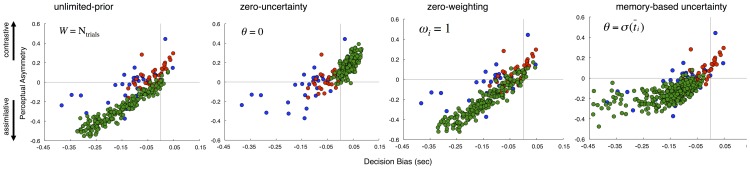
Alternative model comparisons.Each graph displays the results of 200 permutations of an alternative model (green points) compared with the original model (faded points). Four models were tested: an unlimited-prior model, which assumed a perfect memory prior that continuously integrated all perceived intervals across the entire session; a zero-uncertainty model, where uncertainty in the comparison of the present duration with the mean of the prior did not impact decisions and θ was set to zero; a zero-weighting model, in which the prior was still limited and varied between permutations, but no adaptation weighting was applied (all remembered intervals contributed equally to the prior); a memory-based uncertainty model, where θ was set to match the variability of the intervals stored in the limited memory prior. None of the alternative models reproduced the full pattern of data observed in participants or in the full model.